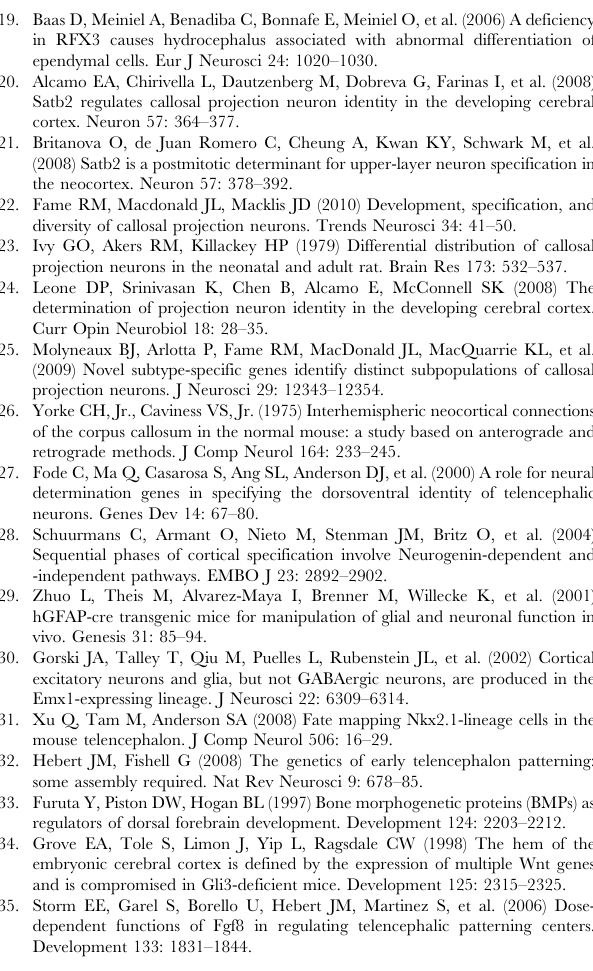
some mutants compare to WT (empty arrows). Bar = 500 m m in all. (TIF) Figure S7 Enlargement of the Fgf8 expression domain in Rfx3 2 / 2 embryos. In situ hybridization for Fgf8 (A and B) and Sprouty2 (C and D) mRNAs on sagittal midline sections from E12.5 WT (A and C) and Rfx3 2 / 2 (B and D) embryos at the CSB. Fgf8 and Sprouty2 expression domains are expanded rostrally and laterally in the pallium of Rfx3 2 / 2 embryos (arrows). Bar= 500 m m in all figures.